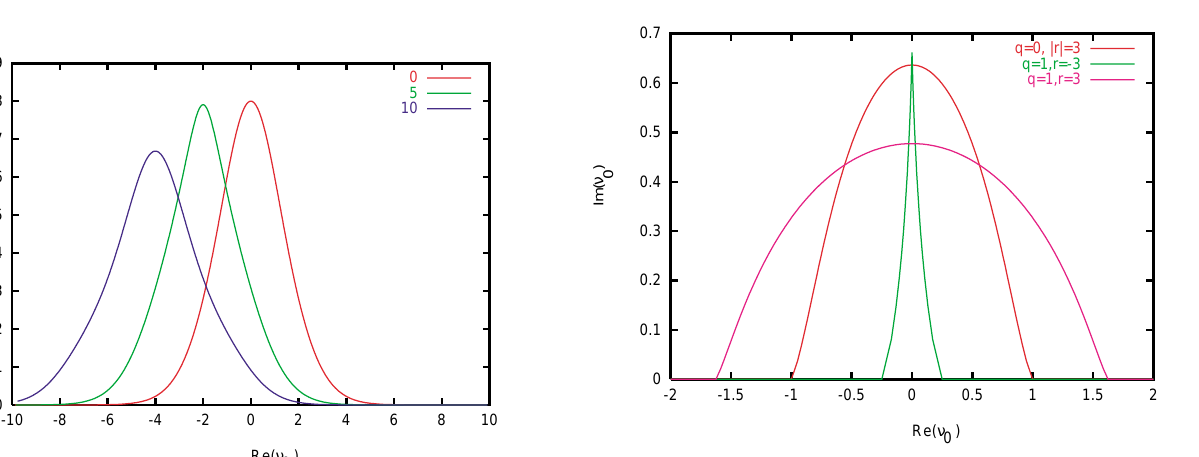
FIG. 8. (Color) Threshold diagrams for tune spread due to oc- tupoles ( r ) with space charge tune spread ( q ). In a real beam the curves would be shifted to the left by (cid:10) 2 q